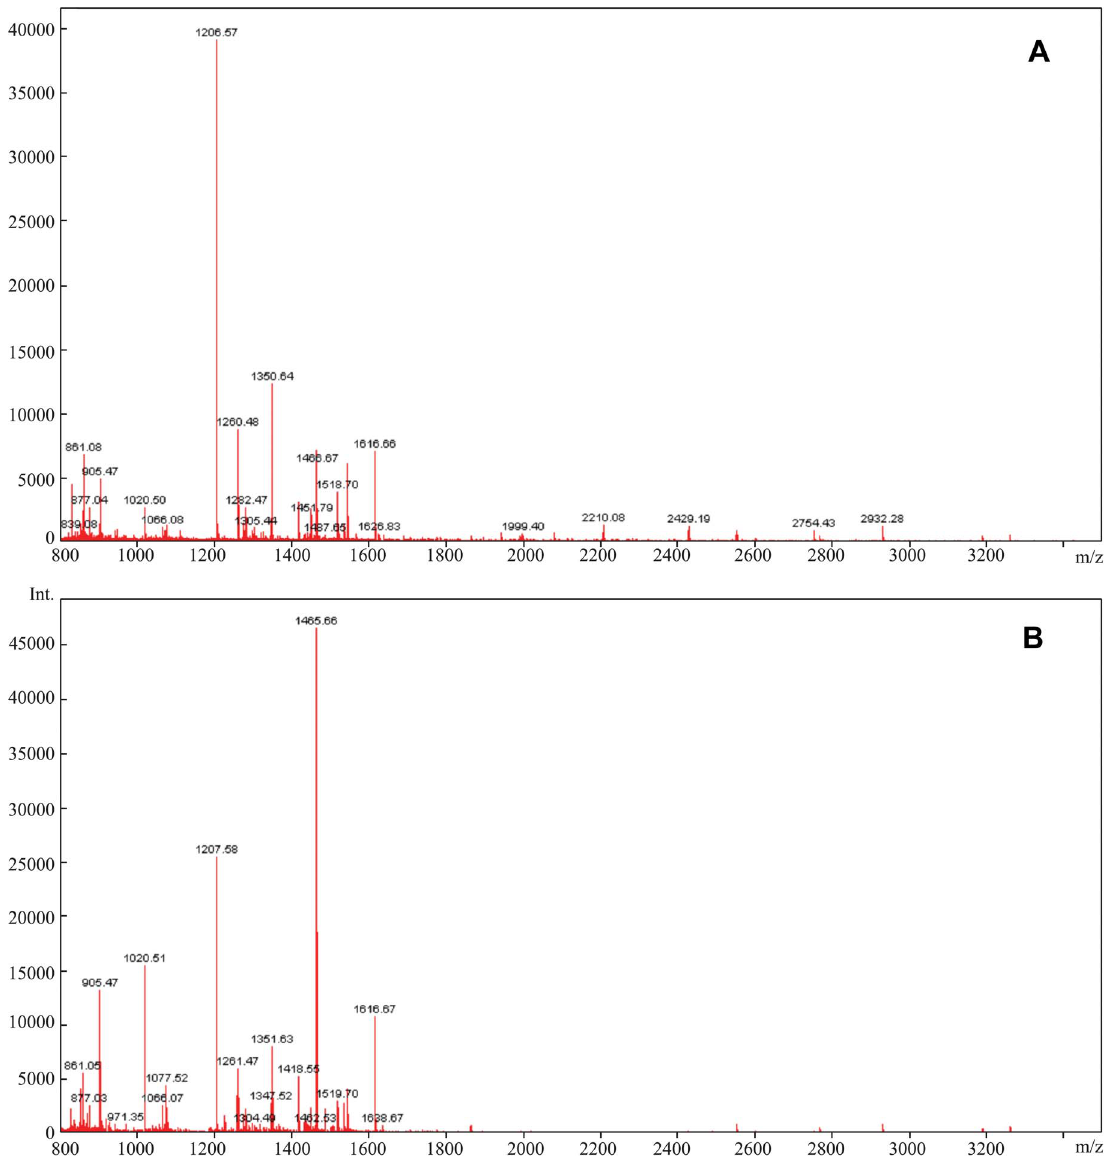
Figure 1. MALDI-TOF MS spectra of one twin pair’s peptide profile using C18 resin. (A) MALDI-TOF MS spectrum of the twin in the disease group. (B) MALDI-TOF MS spectrum of the twin in the control group.